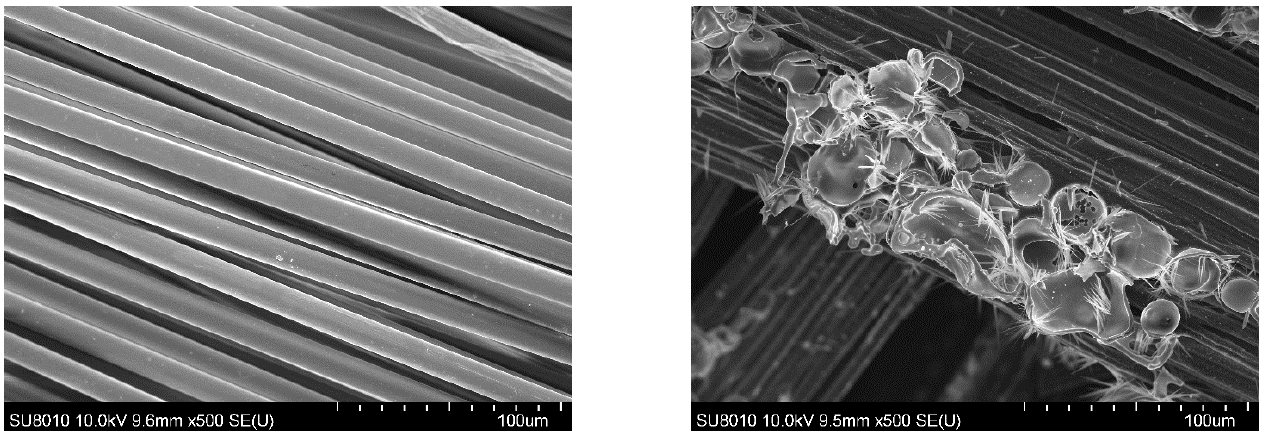
Figure 11. SEM images of A fabrics before CC tests (left column) and top of MGACBSF composites after CC tests (right column).